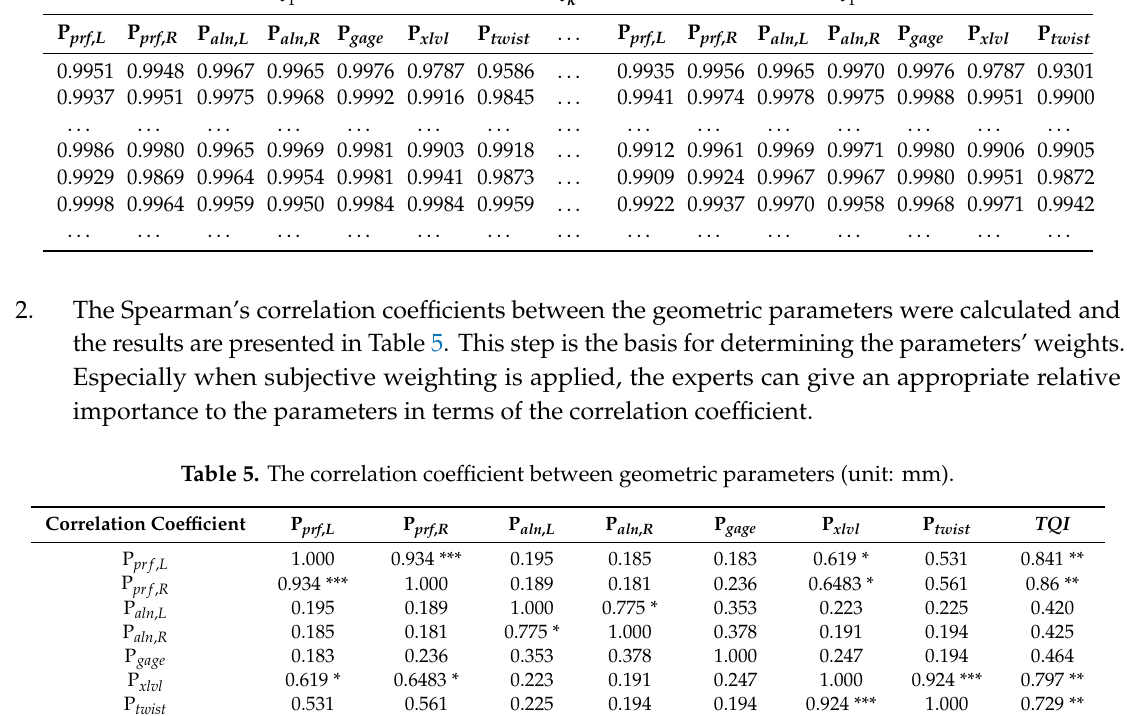
Table 4. Results of data standardization and normalization (unit: mm). t 1